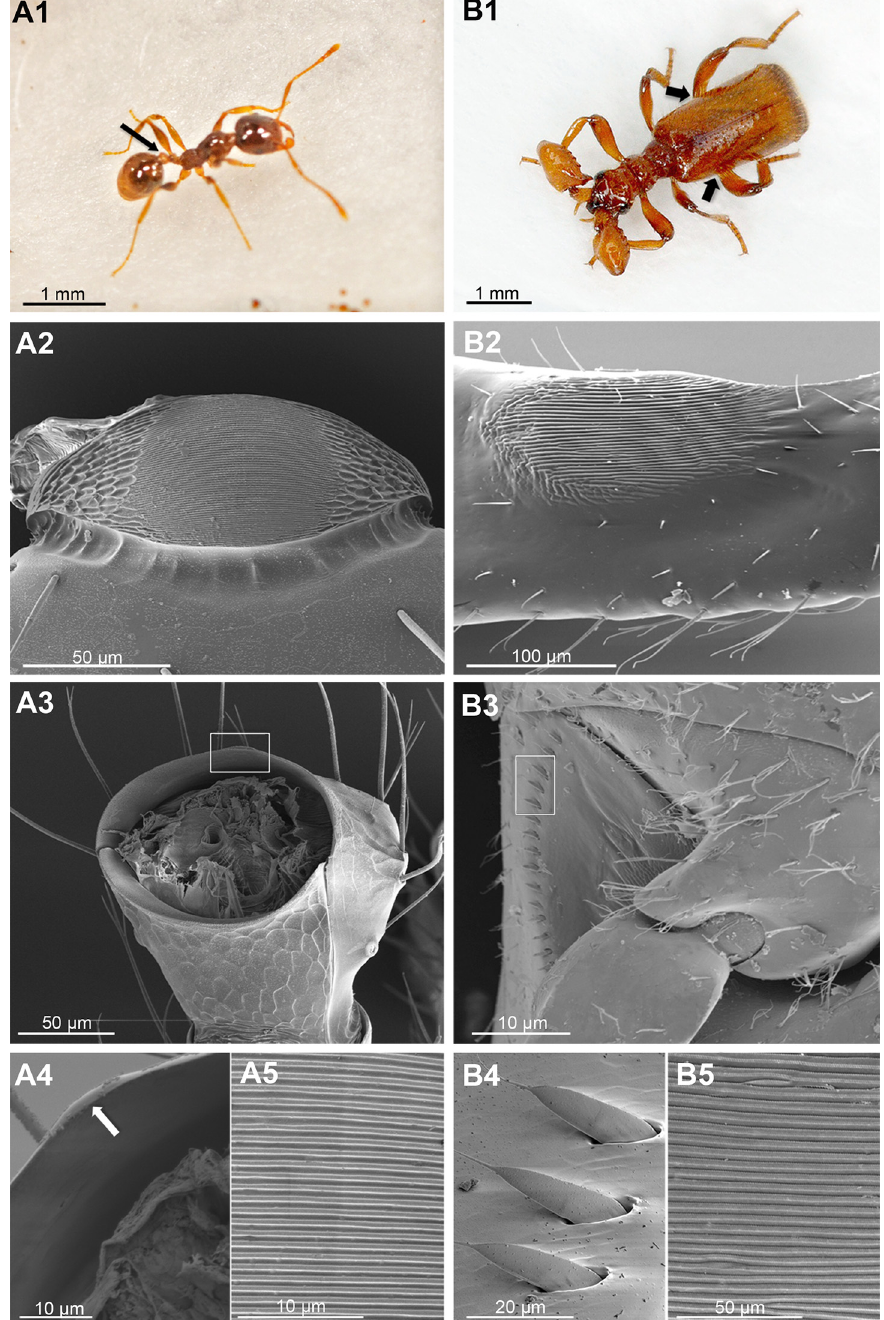
Fig 1. Comparative morphology of stridulatory organs of the ant Pheidole pallidula (a) and the beetle Paussus favieri (b). This figure shows clear similarities between the two structures. A1: P . pallidula worker (photo M. Muzzi), arrow indicates the position of the stridulatory organ. A2 – A5: SEM micrographs of stridulatory organ of P . pallidula composed by a suboval and minutely ridged “ file ” (A2), placed on the meso- dorsal part of the first gastral segment (i.e. the fourth abdominal segment), and a “ scraper ” (A3, rectangular window), consisting of a medial cuticular prominence (A4, arrow) that originates from the posterior edge of the postpetiole (i.e. the third abdominal tergite) (A3); A5 represents a close-up of the ridged stridulatory file of A2. P . pallidula stridulates by quickly moving the gaster up and down. B1: P . favieri (male specimen, photo M. Muzzi), arrows indicate the position of the two stridulatory organs. B2 – B5: SEM micrographs of